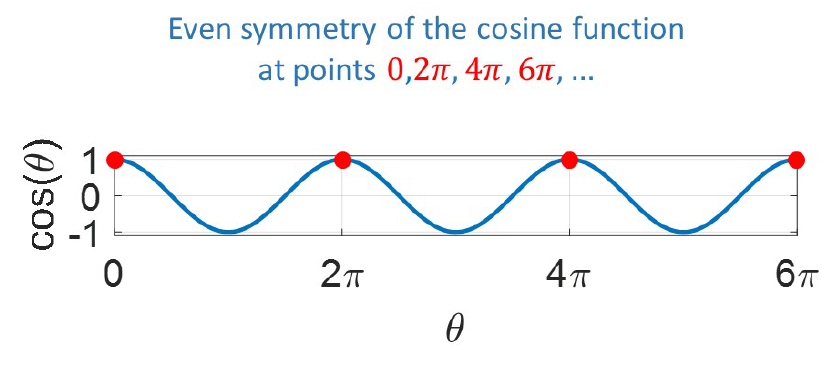
Figure 6. Even symmetry of the cosine function at 2 k π ( k = 0,1,2, . . . ).